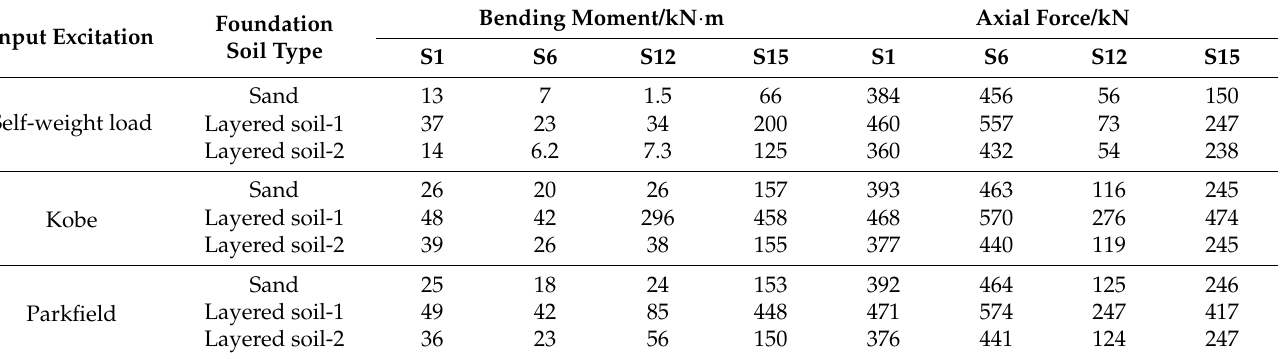
Table 7. The peak values of internal force with various soil foundation